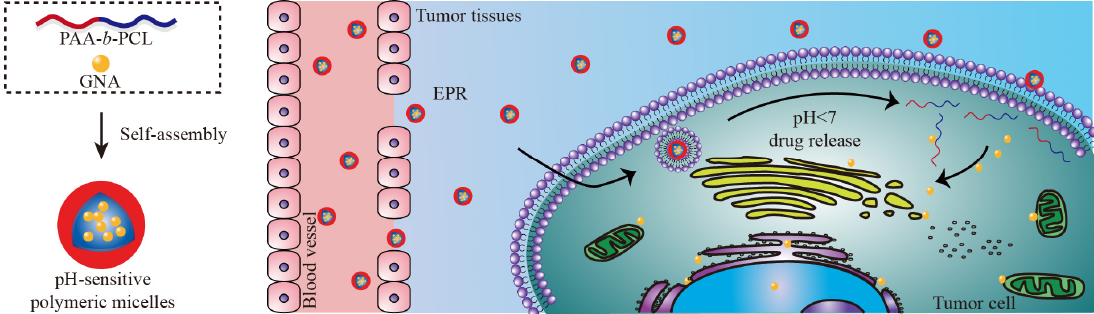
Scheme 1. Schematic illustration of the fabrication of pH-sensitive Polymer Micelles and GNA release from the micelles for cancer therapy.